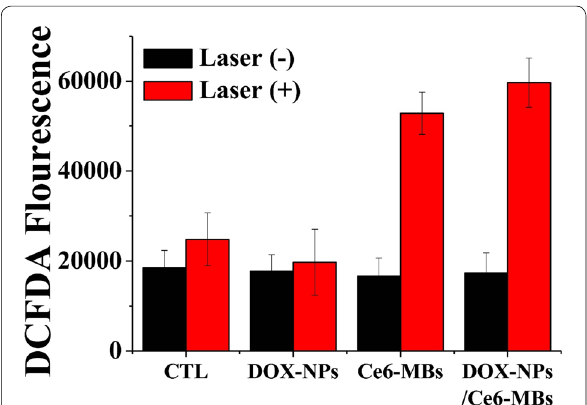
Fig. 4 Intracellular ROS generation. The reactive oxygen species (ROS) generation in MCF-7/ADR cells was determined with or without laser irradiation after DOX-NPs/Ce6-MBs treatment with US irradiation (0.2 W/cm 2 , 50% duty cycle, 30